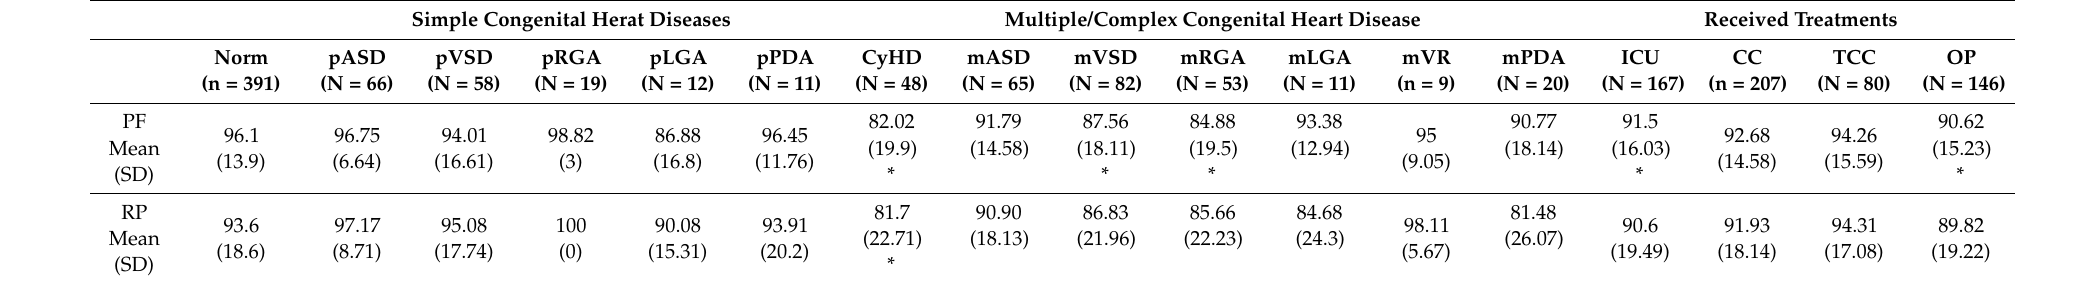
Table 3. Child Health Questionnaire—Parent Form 50 scores in children and adolescents with congenital heart